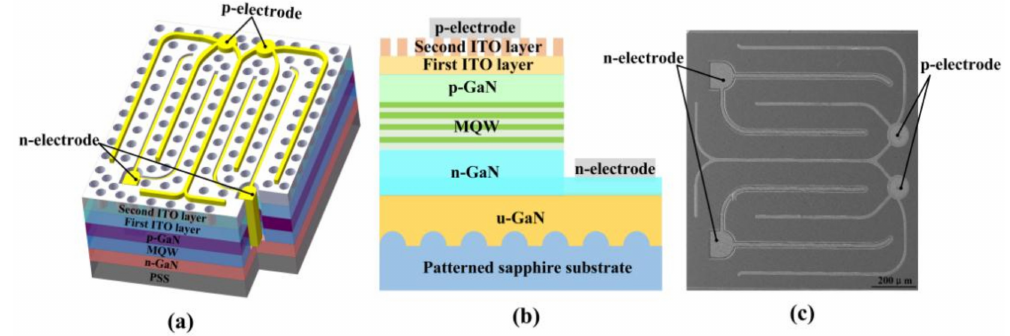
( a ) Schematic representation of the UV LED with a patterned double-layer ITO; ( b ) cross-sectional schematic representation of the UV LED with a patterned double-layer ITO; ( c ) top-view SEM image of the fabricated UV LED